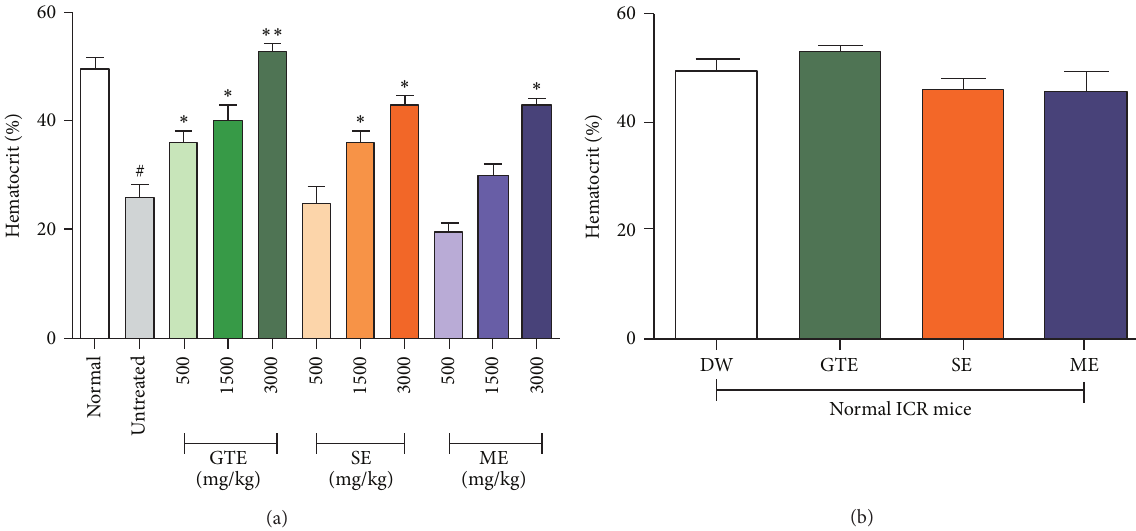
Figure 2: Antihemolytic effects of green tea, safflower, and mulberry extracts against Plasmodium berghei infection. Groups of ICR mice (5 mice of each) were inoculated with 6 × 10 6 infected RBC of PbANKA by IP injection and subsequently given 500, 1500, and 3000 mg/kg of the extracts orally twice a day for 4 consecutive days. On day 5 of experiment, % Hct was measured in (a) infected mice treated with these extracts. In addition, (b) % Hct of normal mice treated with these extracts was also measured. Results were presented as mean ± SD. # 𝑃 < 0.01 compared to normal; ∗ 𝑃 < 0.05 and ∗∗ 𝑃 < 0.01 compared to untreated control. GTE: green tea extract, SE: safflower extract, and ME: mulberry